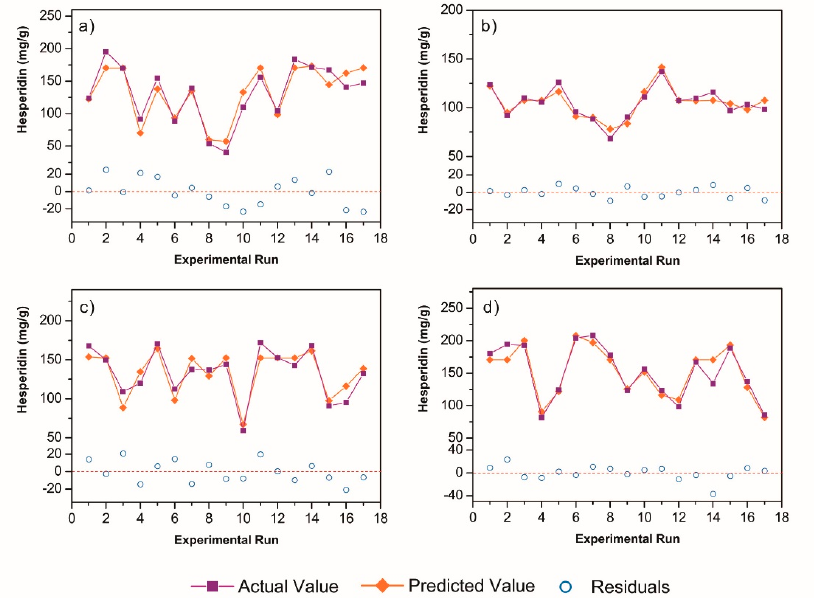
Figure 4. Graphical comparison of actual and predicted values of the extracted hesperidin content for each variety of mandarin: ( a ) Okitsu ; ( b ) Chahara ; ( c ) Kuno ; ( d ) Zorica Rana.